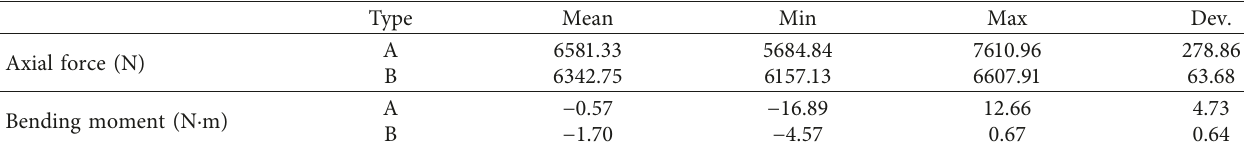
Figure 10: Axial force and bending moment of two different kinds of pull rods. (a) Axial force. (b) Bending moment. Table 2: Statistical results of the axial forces and the bending